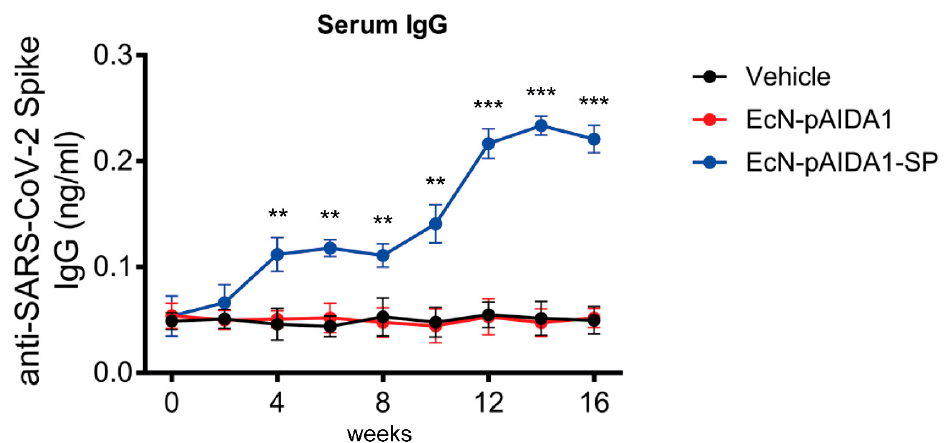
Figure 3. E. coli Nissle pAIDA1-Spike triggered IgG(s) production after oral administration. IgG titre in sera samples of mice treated with control (black), EcN-pAIDA1 2 × 10 9 CFU (red), and EcN-pAIDA1-SP 2 × 10 9 CFU (blue) at weeks 0, 2, 4, 6, 8, 10, 12, 14, and 16. Results are expressed in mean ± SD of n = 4 experiments performed in triplicate. (** p < 0.01 vs. control group, *** p < 0.001 vs. control group).